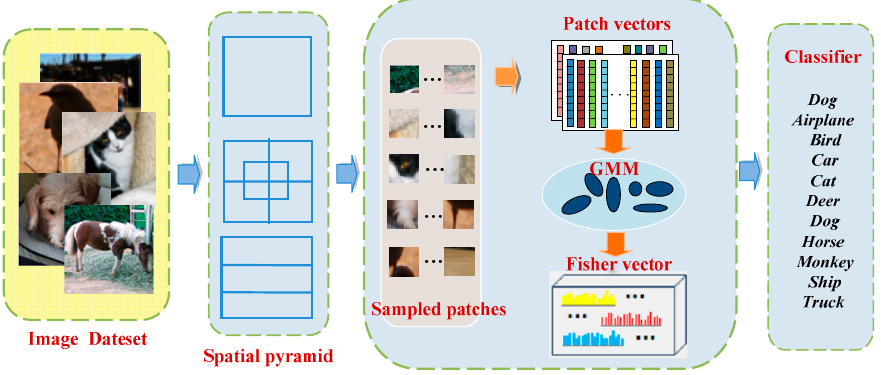
Figure 3. The proposed image classification framework.